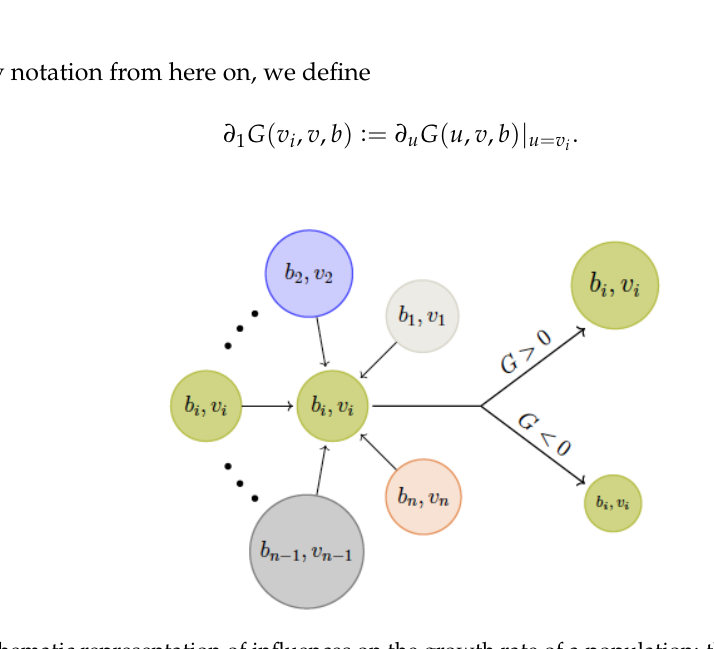
Figure 1. Schematic representation of influences on the growth rate of a population: the growth rate G of a subpopulation will be mainly influenced by three factors: its own strategy v i , the environment defined by the complete strategy set v and the whole population b